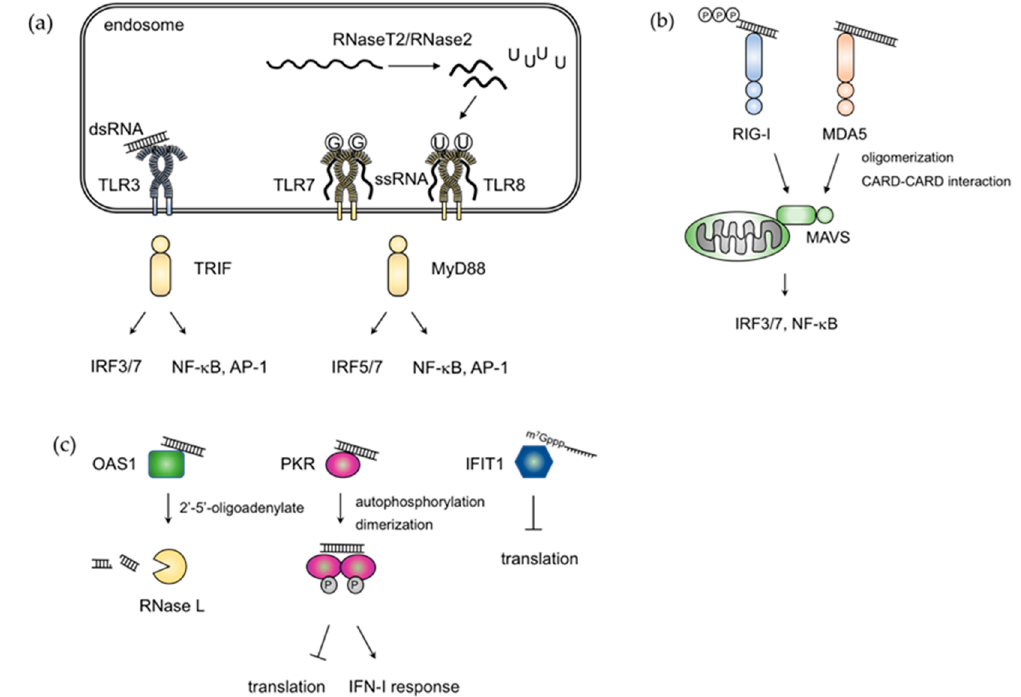
Figure 2. RNA sensing mechanisms. RNA sensing mechanisms are composed of endosomal and cytoplasmic sensors. ( a ) Endosomal RNA sensors, TLR3 and TLR7 / 8, recognize dsRNA and ssRNA, respectively. TLR3 activates the TRIF-dependent pathway to activate IRF3 / 7, NF- κ B, and AP-1. In contrast, TLR7 / 8 triggers the MyD88-dependent pathway and leads to the activation of NF- κ B and AP-1, and simultaneously activates IRF5 / 7 to induce type I IFN genes. In addition to recognizing ssRNA, TLR7 and TLR8 can be activated by guanosine and uridine residues, respectively. Uridine molecules for TLR8 are degraded products generated by RNaseT2 and RNase2, although it remains unknown how guanosine residues are generated. The engagement of both ligands achieves maximum activation of TLR7 / 8. ( b ) RIG-I and MDA5 are central RNA sensors that localize to the cytosol, and both harbor the N-terminal tandem caspase-recruitment domains (CARDs) and helicase domains. After binding to dsRNA, these RNA sensors undergo oligomerization along dsRNA structures, which then activates MAVS through CARD–CARD interaction. These sequential events then activate IRF3 / 7 along with NF- κ B to induce IFN-I responses. ( c ) Alternative RNA sensing is mediated by RNA receptors whose expressions are induced by RLR activation. OAS1 generates 2 ′‐ 5 ′‐ oligoadenylate that activates RNase L, which promotes the degradation of dsRNAs. The resulting fragments of dsRNAs can also activate the RIG ‐ I ‐ like receptor (RLR) ‐ sensing pathway. PKR is a Ser/Thr protein kinase that is present in the unphosphorylated form. After binding to dsRNA, PKR undergoes autophosphorylation and dimerization, which inhibits viral protein synthesis and induces the IFN ‐ I response. IFIT1 recognizes capped RNA with 5’ ‐ triphosphate ends, which can block the translation of viral RNA. U, uridine; G, guanosine; IFN ‐ I, type I interferon; CARD, caspase activation recruitment domain.